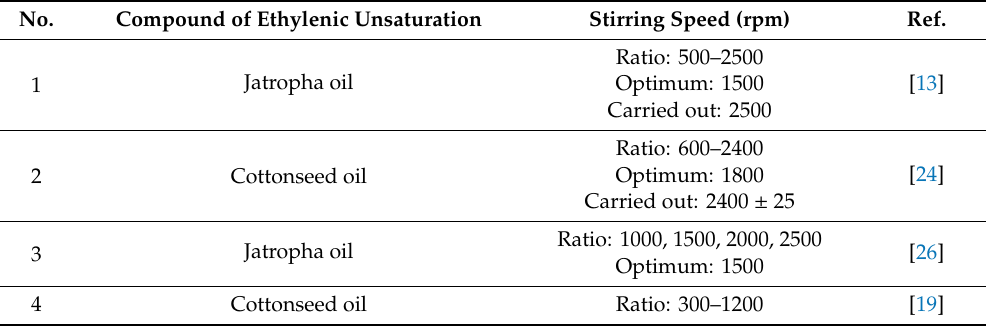
Table 5. Stirring speed of